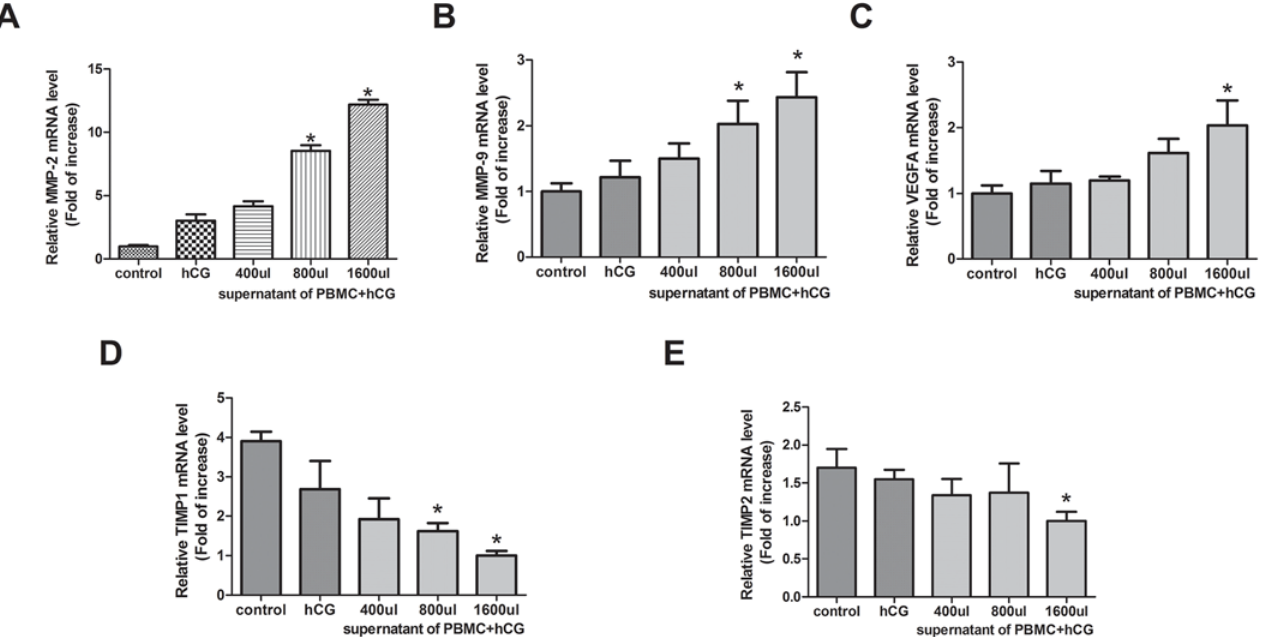
Fig 4. The effect of peripheral blood mononuclear cells (PBMC) activated by human chorionic gonadotropin (hCG) on mRNA expression of matrix metalloproteinase (MMP)-2, MMP-9, vascular endothelial growth factor (VEGF), and tissue inhibitor of metalloproteinase (TIMP)-1 and TIMP-2 in JAR cells by real-time polymerase chain reaction. The mRNA expression of MMP-2, MMP-9, VEGF, TIMP-1, and TIMP-2 in control JAR cells and those cultured in hCG, 400, 800, or 1600 μ L of culture medium supernatant of PBMC with hCG. Data are expressed as mean ± standard error of the mean of triplicate experiments. * , P < 0.05 compared with the control and hCG groups.